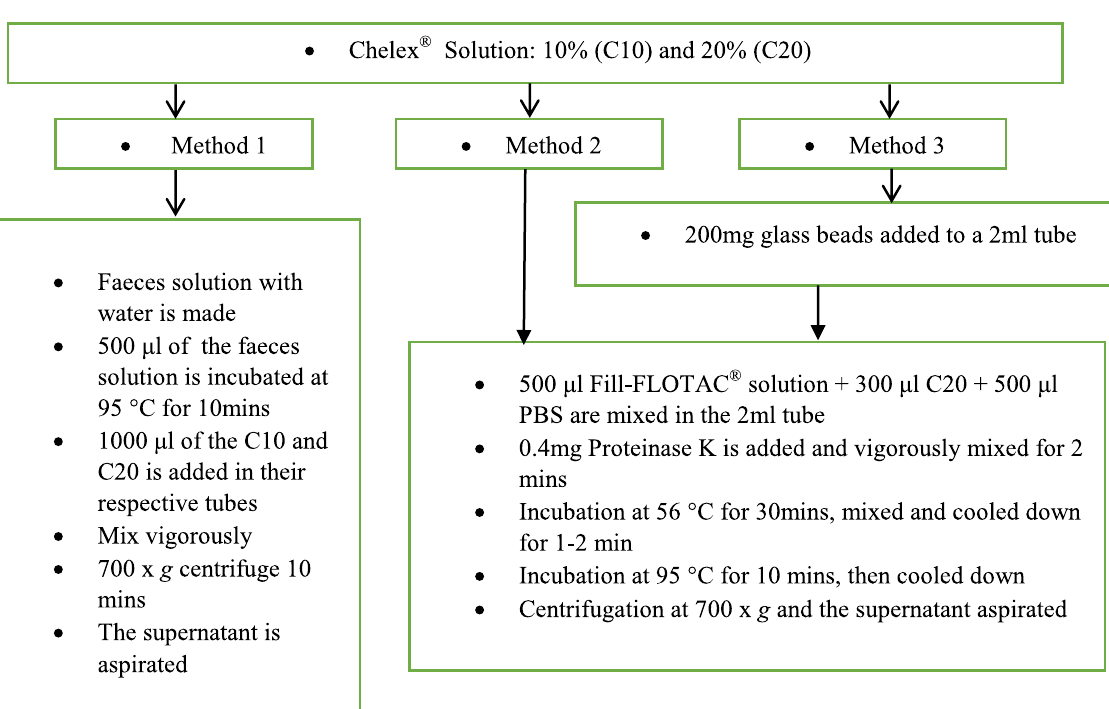
Fig. 1. Steps for the crude DNA extractions trials based on Chelex (cid:1)